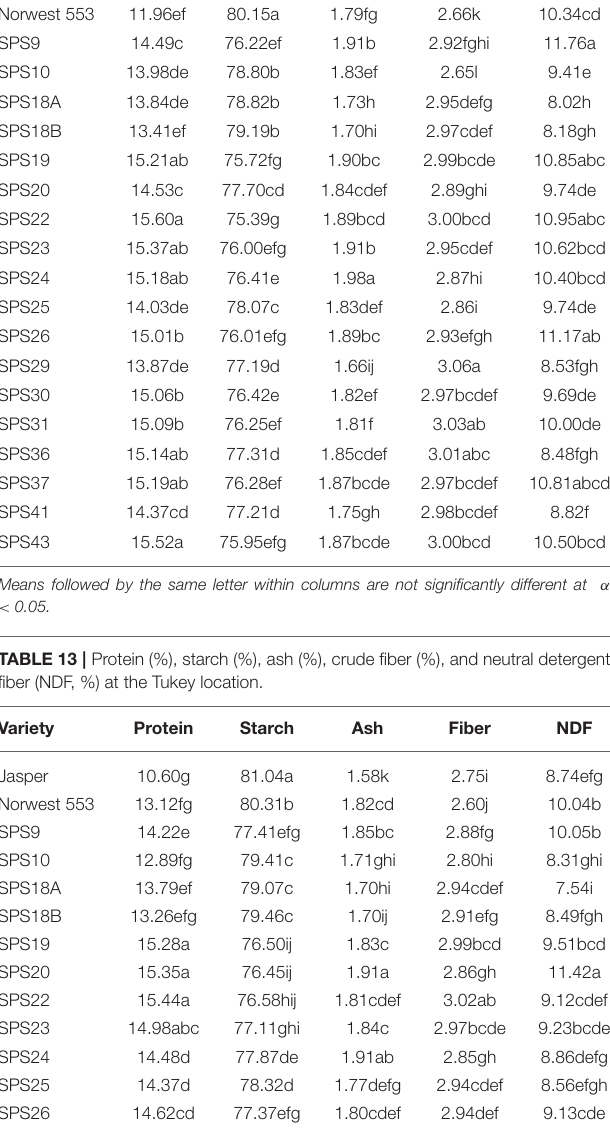
TABLE 11 | Grain hardness (SK hardness index) and grain diameter (mm) for varieties at Higbee and Tukey locations. Higbee Tukey Variety